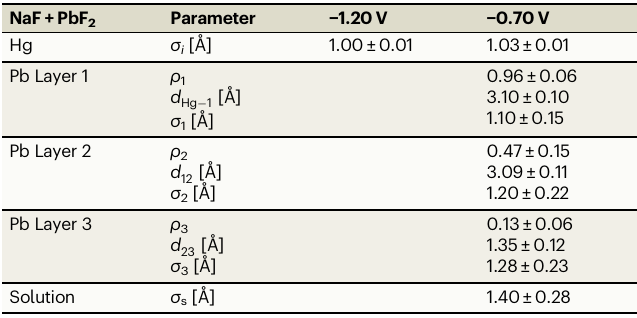
Table3 | Structuraldata on the adlayer formed in F-containing solution